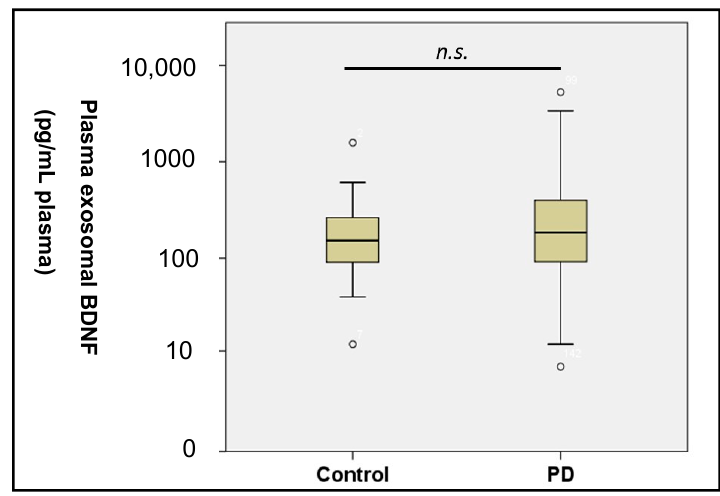
Figure 2. Plasma exosomal brain-derived neurotrophic factors (BDNF) levels among controls and patients with Parkinson’s disease (PD). Data are presented as the median, first quartile, third quartile, and variation. n.s. , nonsignificant.